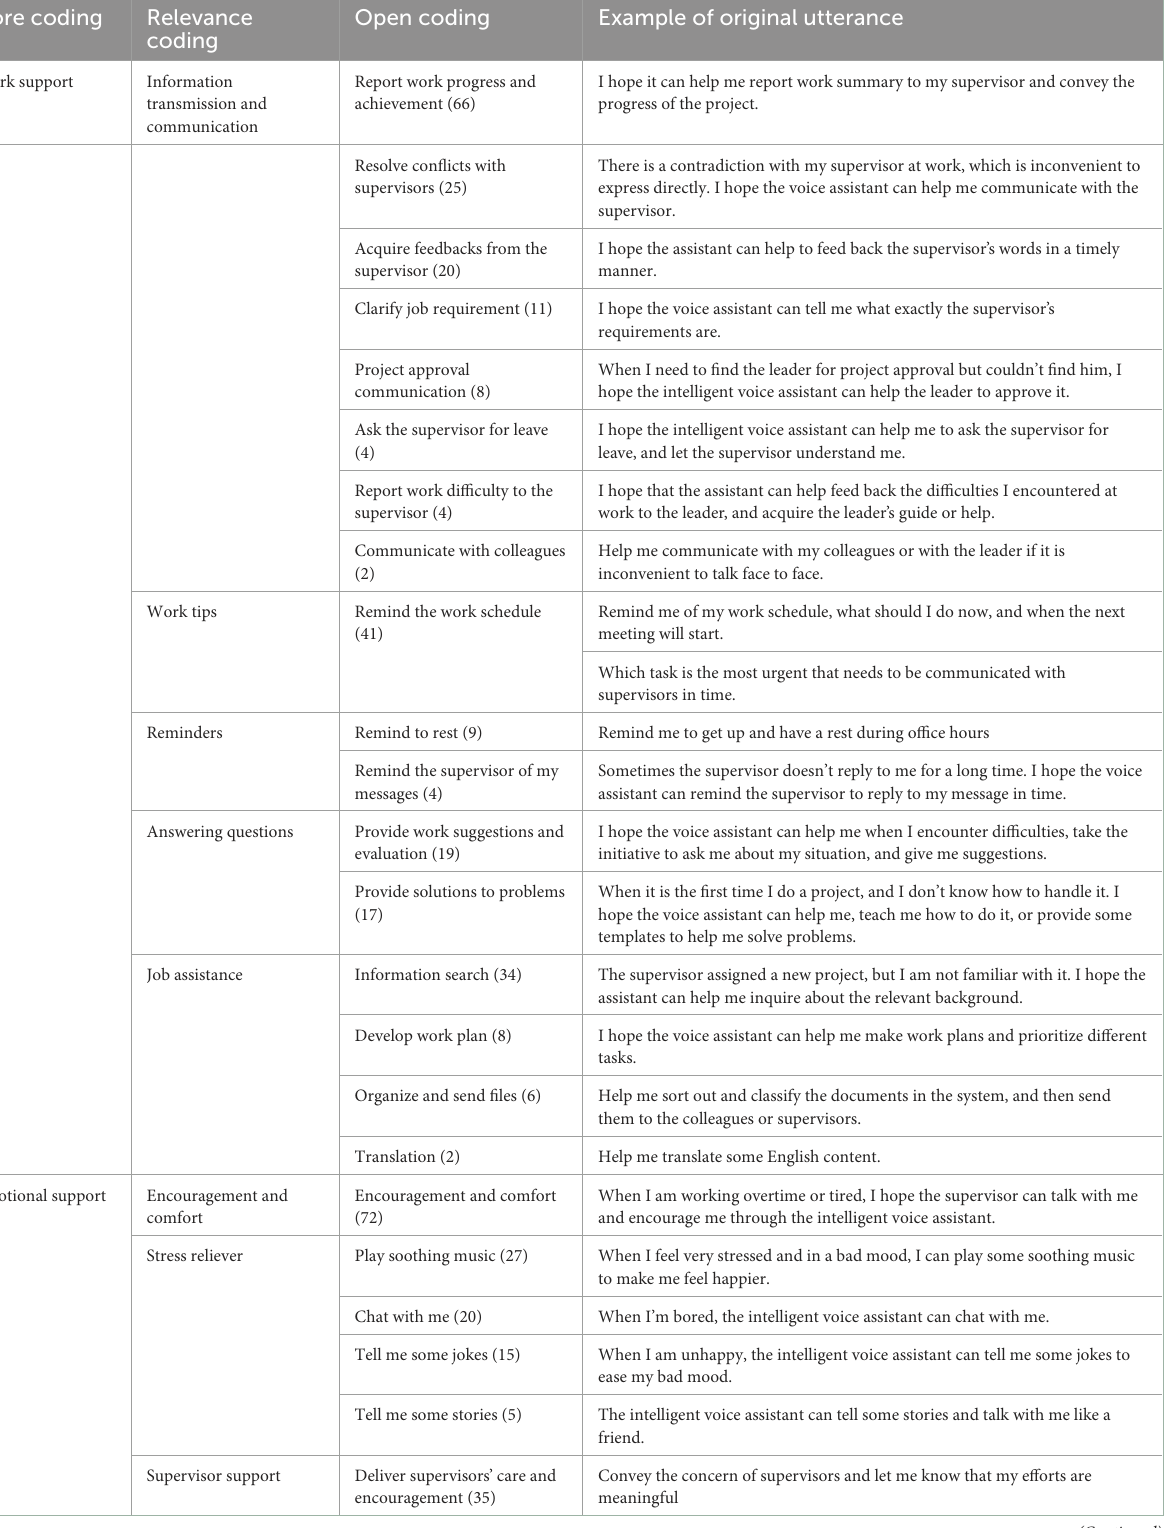
TABLE 1 Qualitative coding of knowledge workers’ interview responses on IVA needs. Core